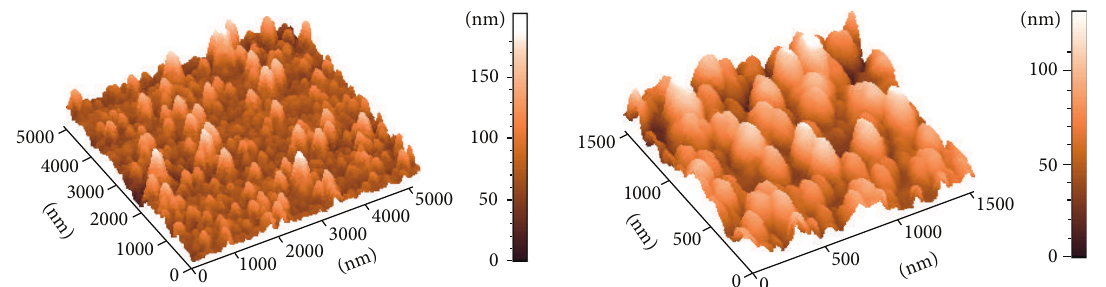
Figure 2: Typical AFM images with different magnifications for ZnO:In thin film doped by 1at.% impurity.